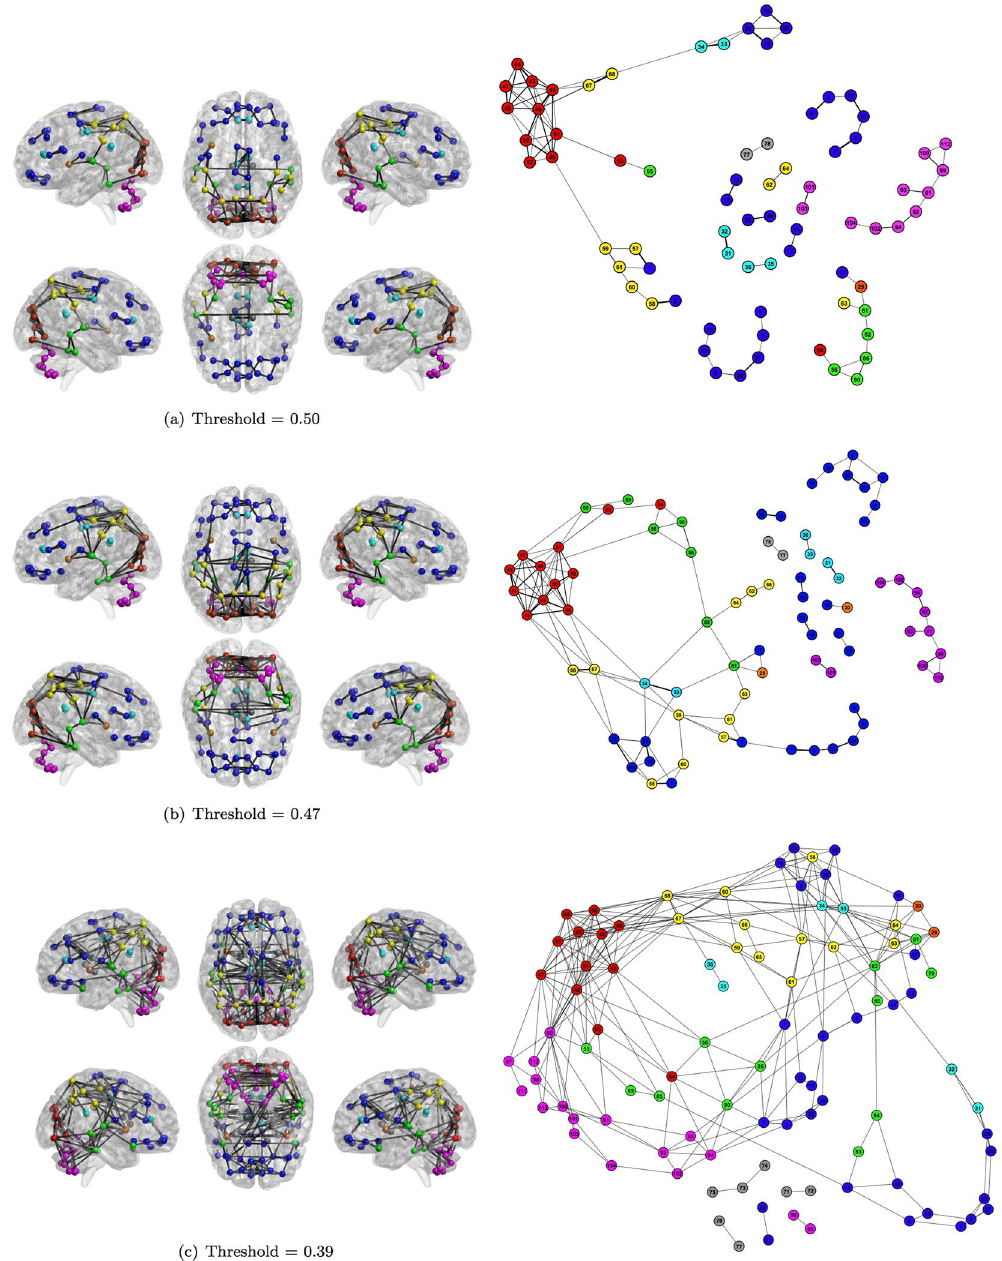
Figure 7. Snapshots of the human functional brain network. Each snapshot is realized thresholding the correlation matrix. Thresholds are chosen looking at the most significant deviation of plateaux length of the real percolation curve from its ensemble of randomization (Fig. 2(b)). Colors represent anatomical regions according to the grouping of AAL parcellation in Fig. 3(a): Frontal Lobe; Insula; Cingulate; Temporal Lobe; Occipital Lobe; Parietal Lobe; Deep Grey Matter; Cerebellum. Link thickness represents the strength of